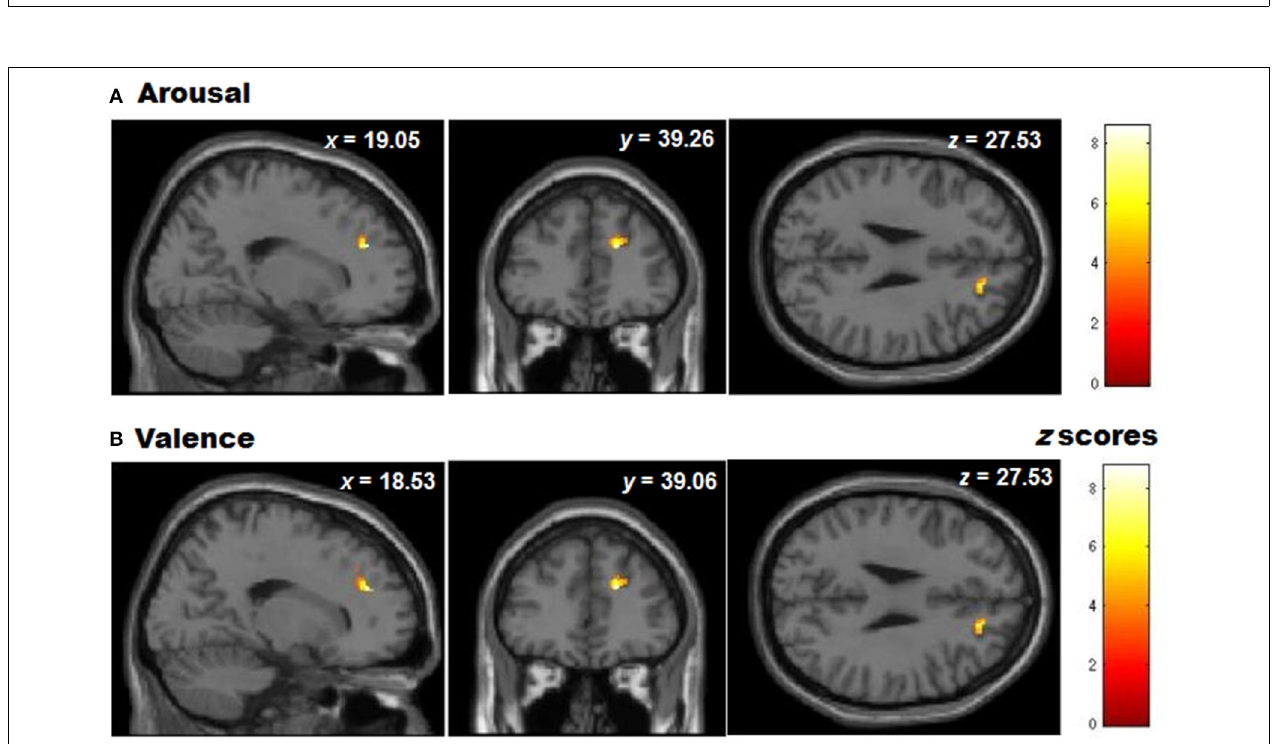
FIGURE 7 | Graphic display of regional gray matter patterns of volume using the ROI depicted by the VLSM analysis (BA9/32) correlated with task performance in controls for (A) Arousal and (B) Valence rating differences (presented at a level of p < 0 . 05 unc).